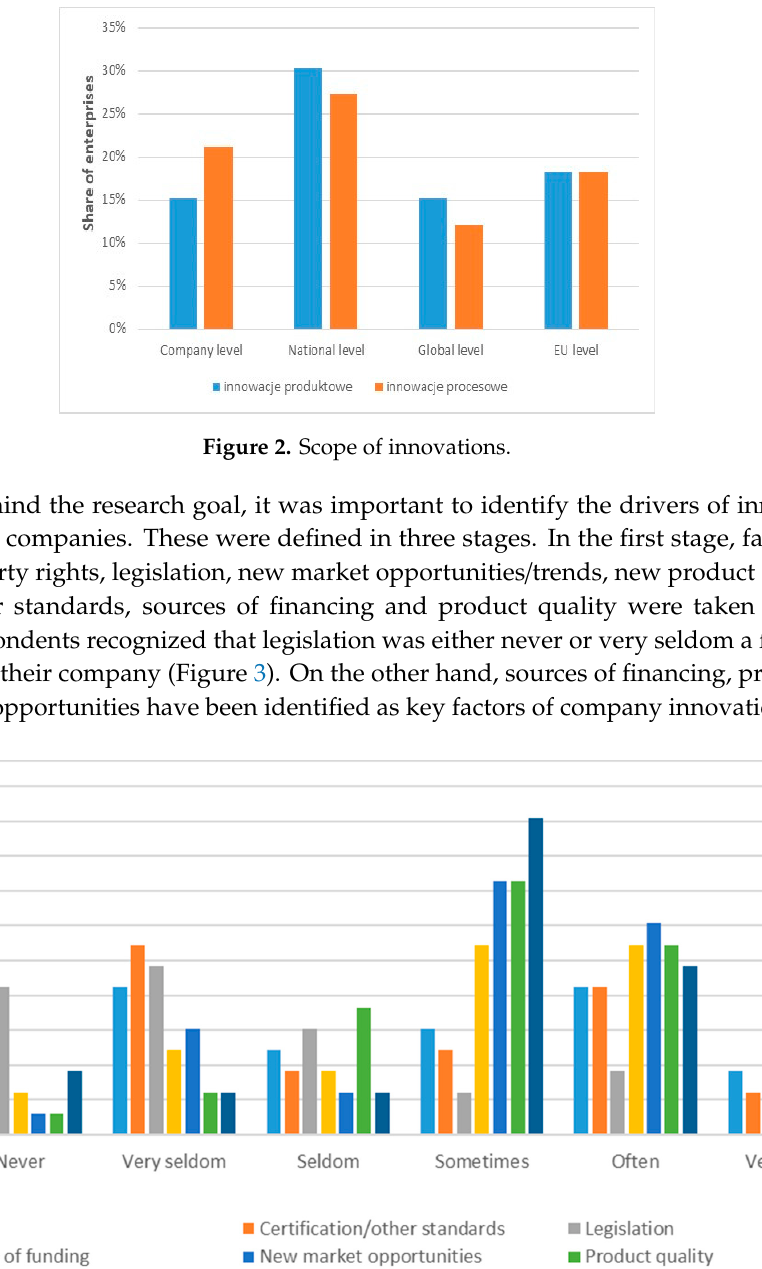
Figure 3. Drivers of innovation (part 1) .